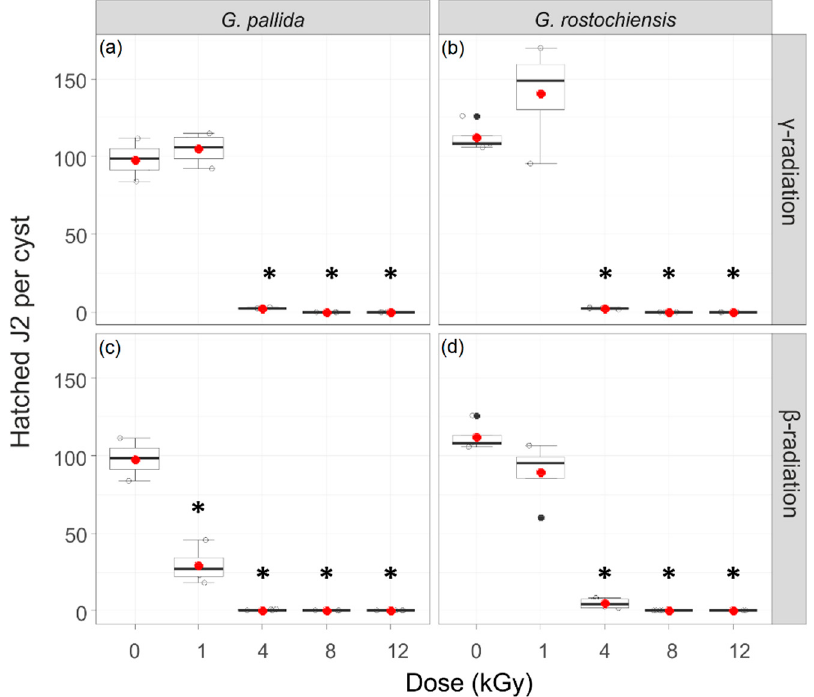
Figure 1. Hatching test for G. pallida and G. rostochiensis γ and β irradiated cysts. Total number of hatched juveniles (J2) per cyst over a period of seven weeks for 0, 1, 4, 8 and 12 kGy γ irradiated G. pallida ( a ), γ irradiated G. rostochiensis ( b ), β irradiated G. pallida ( c ) and β irradiated G. rostochiensis ( d ) cysts. Data were analysed by the non-parametric Kruskal–Wallis test with the pairwise Wilcoxon post hoc test using adjusted p -values. Box–whisker plots display the median and mean (red dots) values of four replicates with 20 cysts each. Asterisks indicate the significant differences to the respective non-treated controls.